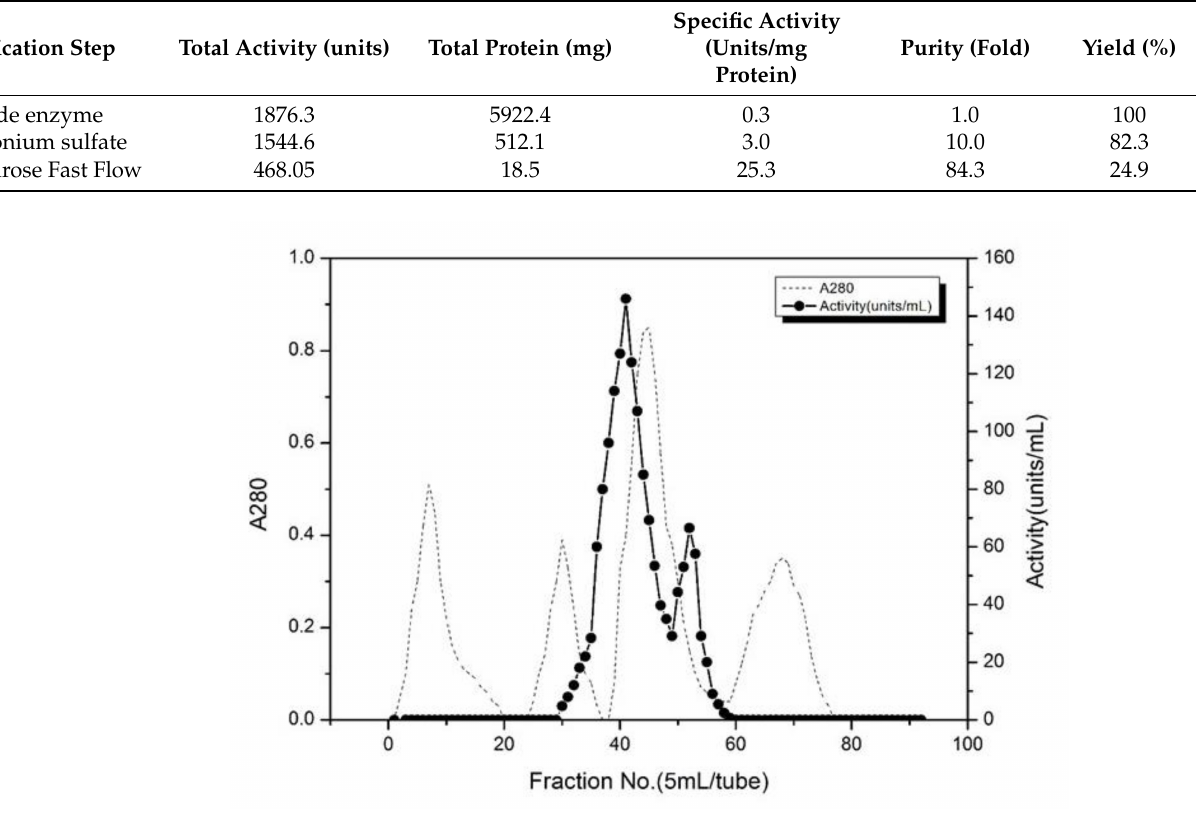
Figure 1. Elution profile of trypsin extracted from Litopenaeus vannamei , on Q-Sepharose anion exchange column. The graph shows a typical result of several repeated